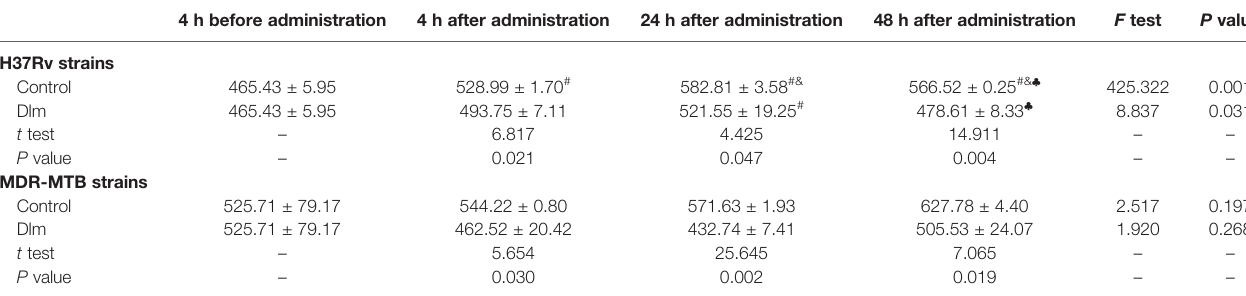
TABLE 5 | The level of IL-10 in the culture supernatant of macrophages infected by MDR-MTB after Dlm was administered (pg/ml, (cid:1) x ± s ).